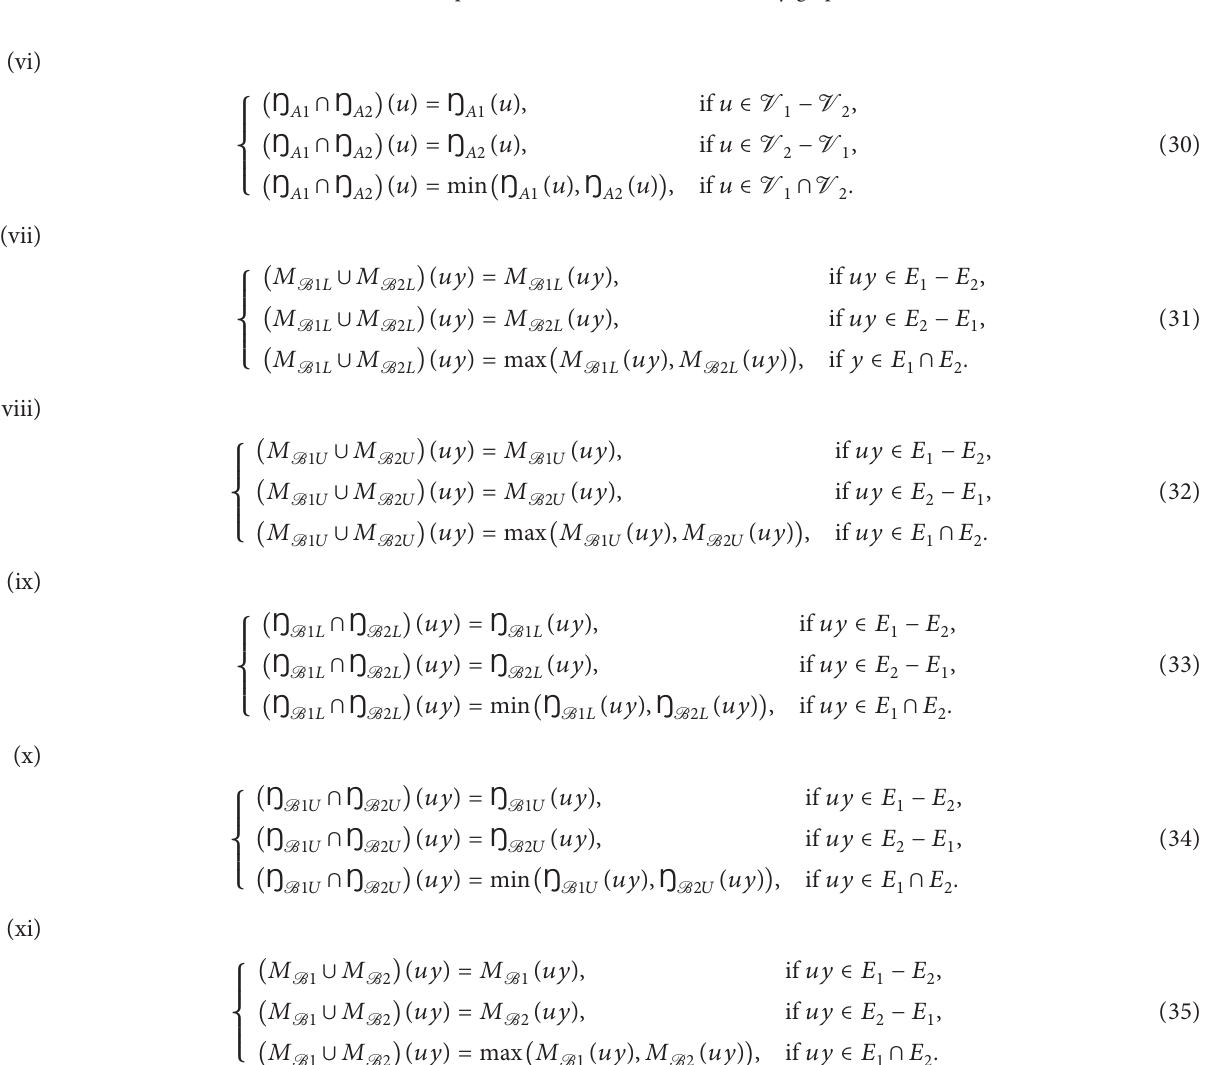
Figure 15: Composition of cubic intuitionistic fuzzy